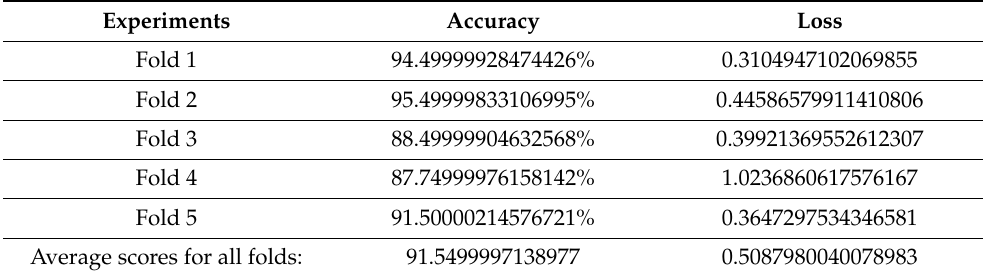
Table 14. Performance of the proposed model on Hockey Fight dataset on cross folds k = 5